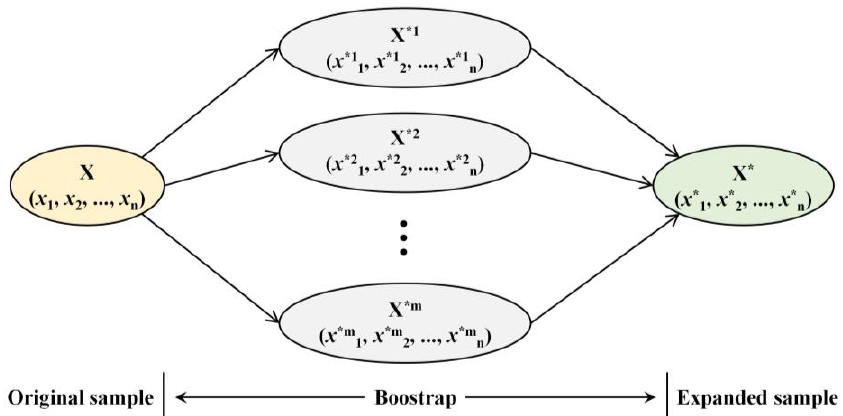
Figure 2. Schematic of the bootstrap method.